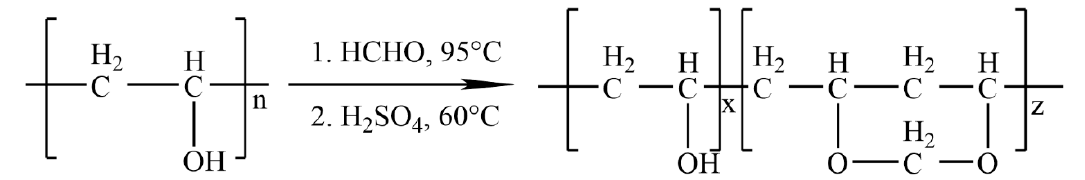
Scheme 1. Preparation of polyvinyl formaldehyde from polyvinyl